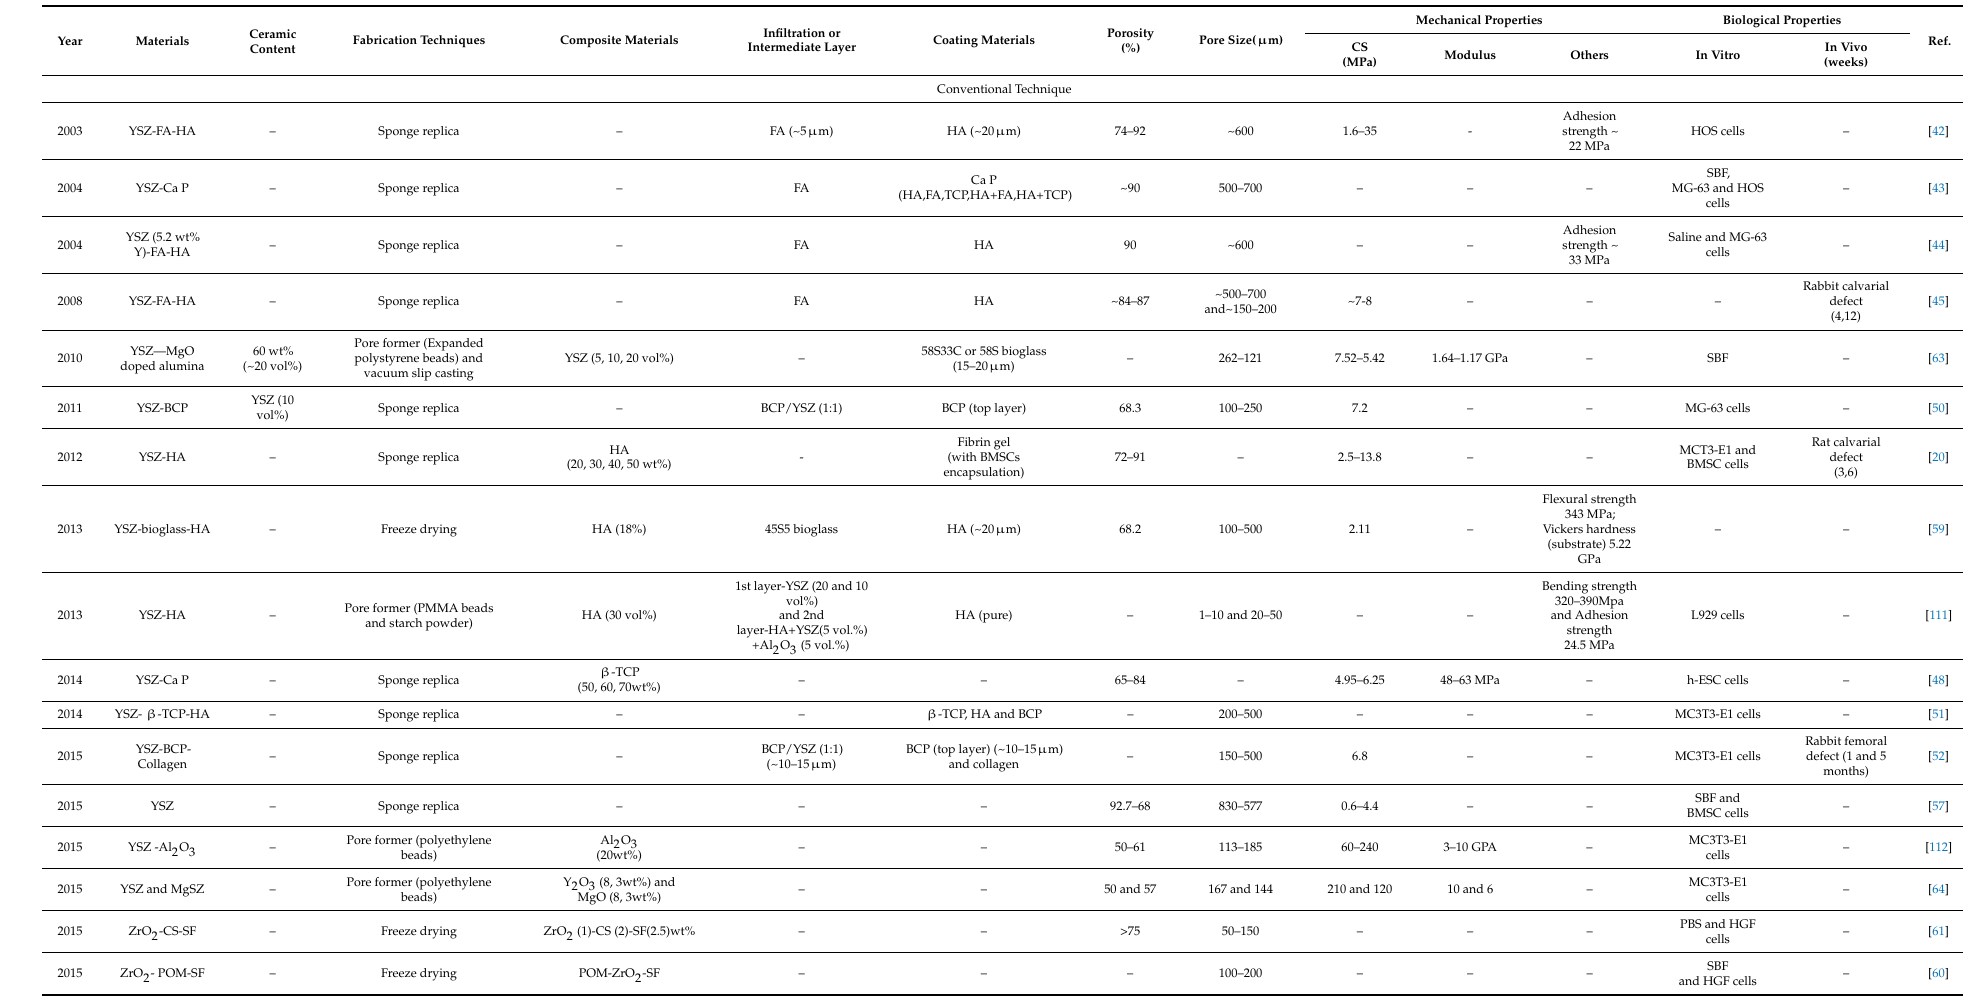
Table 1. A summary of the zirconia based scaffolds for bone tissue engineering applications based on fabrication/design and its